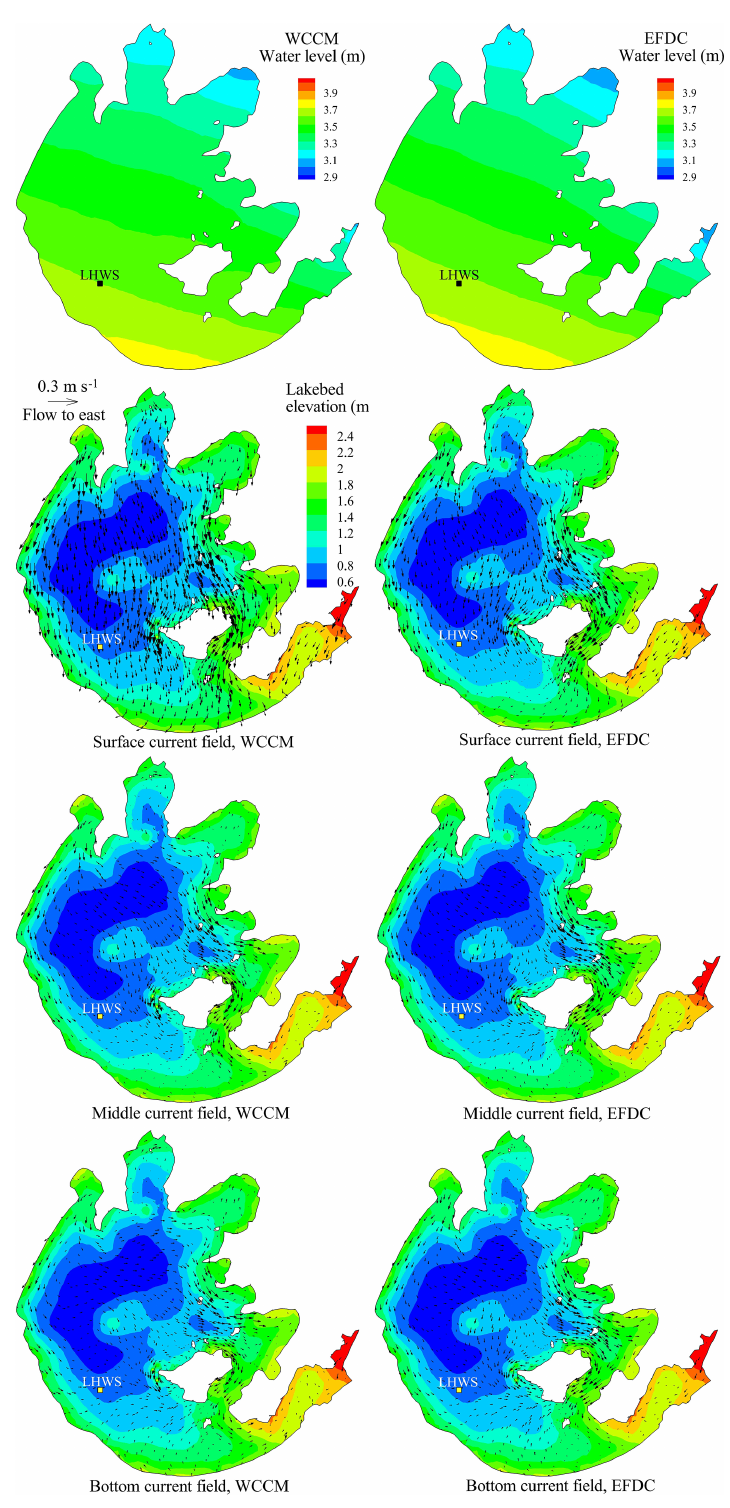
Figure 12. Comparison of the contour of the water level and surface, middle, and bottom current fields simulated by the WCCM with those simulated by the EFDC at 22:00LT on 26 December